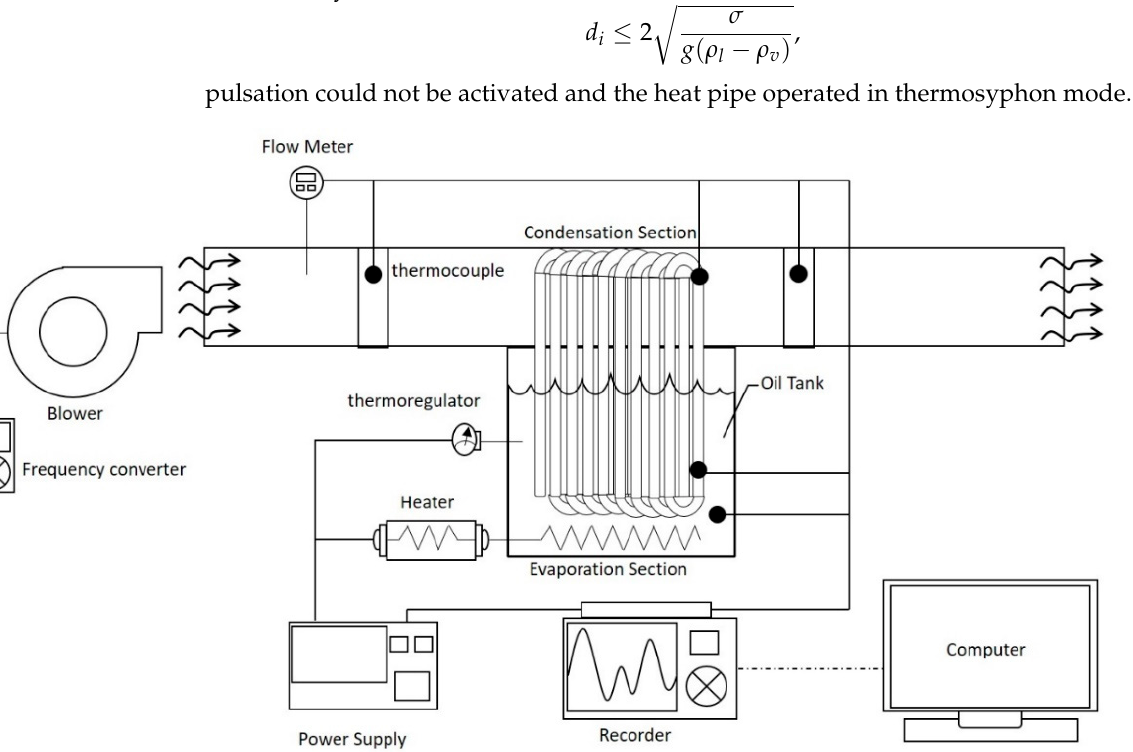
( b ) Figure 2. ( a ) The detailed configuration of the present HPHX. ( b ) An actual example (unit: mm ).